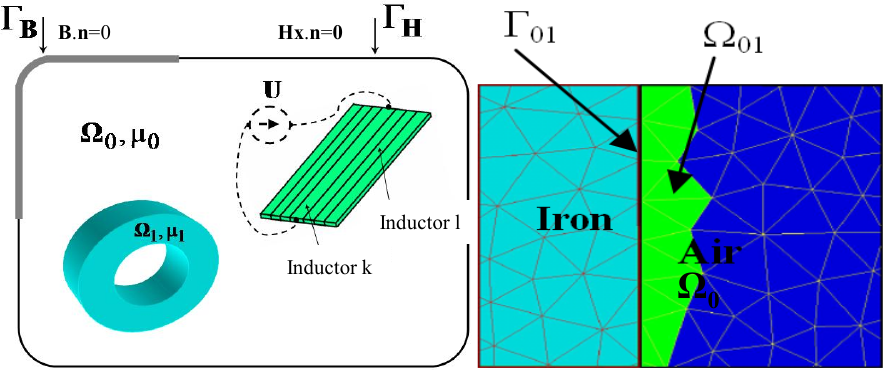
Figure 3. General description of FEM-PEEC coupled